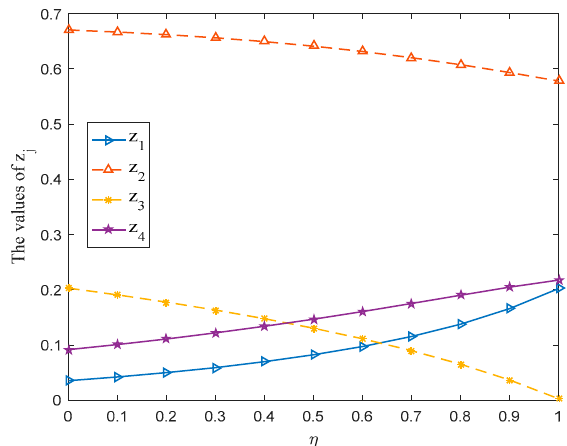
Figure 6. z j with parameter η varying from 0 to 1.